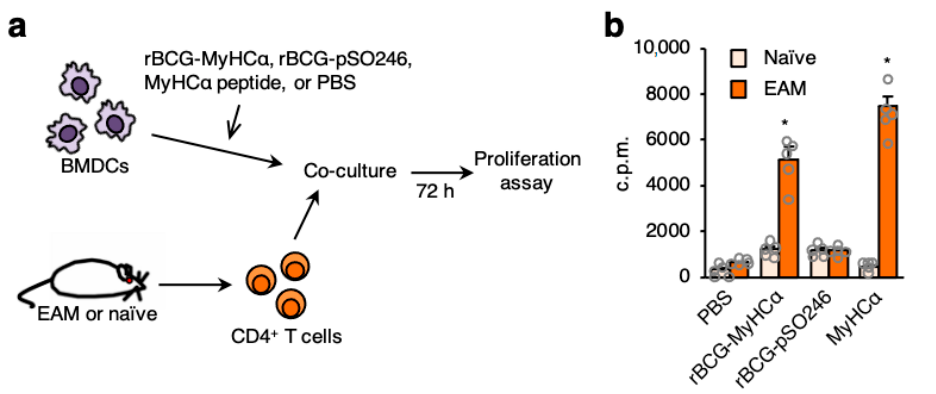
Figure 9. rBCG-MyHC α -infected DCs induced MyHC α -specific CD4 + T-cell proliferation. ( a ) EAM was induced by immunization with MyHC α peptide emulsified in CFA. CD4 + T cells were isolated from spleens of EAM or naïve mice and co-cultured with rBCG-infected BMDCs, MyHC α -loaded BMDCs, or non-stimulated BMDCs (PBS). ( b ) T-cell proliferation was assessed by measurement of [ 3 H]-thymidine incorporation. The values are expressed as means ± SEM of pentuiplicate wells. * p < 0.05 vs. naive by one-way ANOVA with Tukey’s post hoc